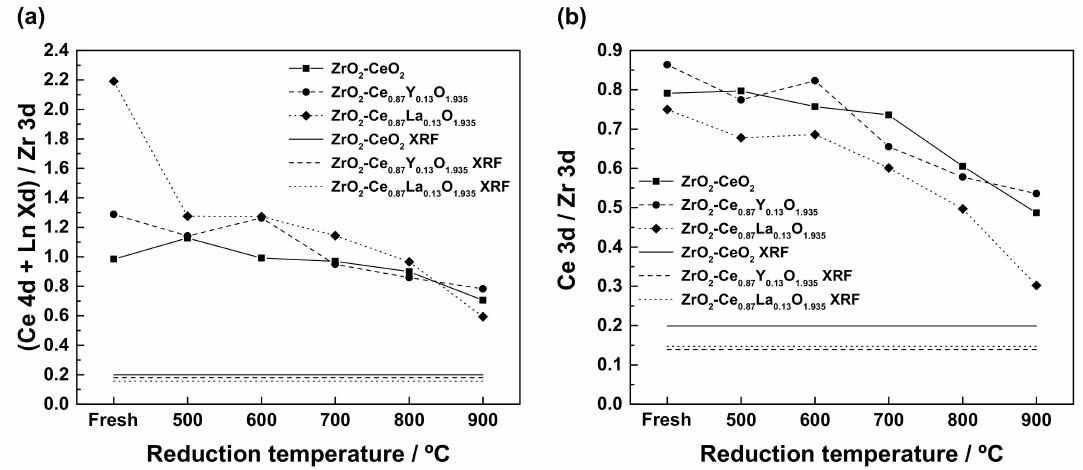
Figure 11. Evolution of the ( a ) (Ce 4 d + Ln X d ) / Zr 3 d and ( b ) Ce 3 d / Zr 3 d ratios, with the maximum temperature of the last reduction treatment for the undoped and Ln-doped ZrO 2 -CeO 2 samples during the application of the successive thermochemical ageing